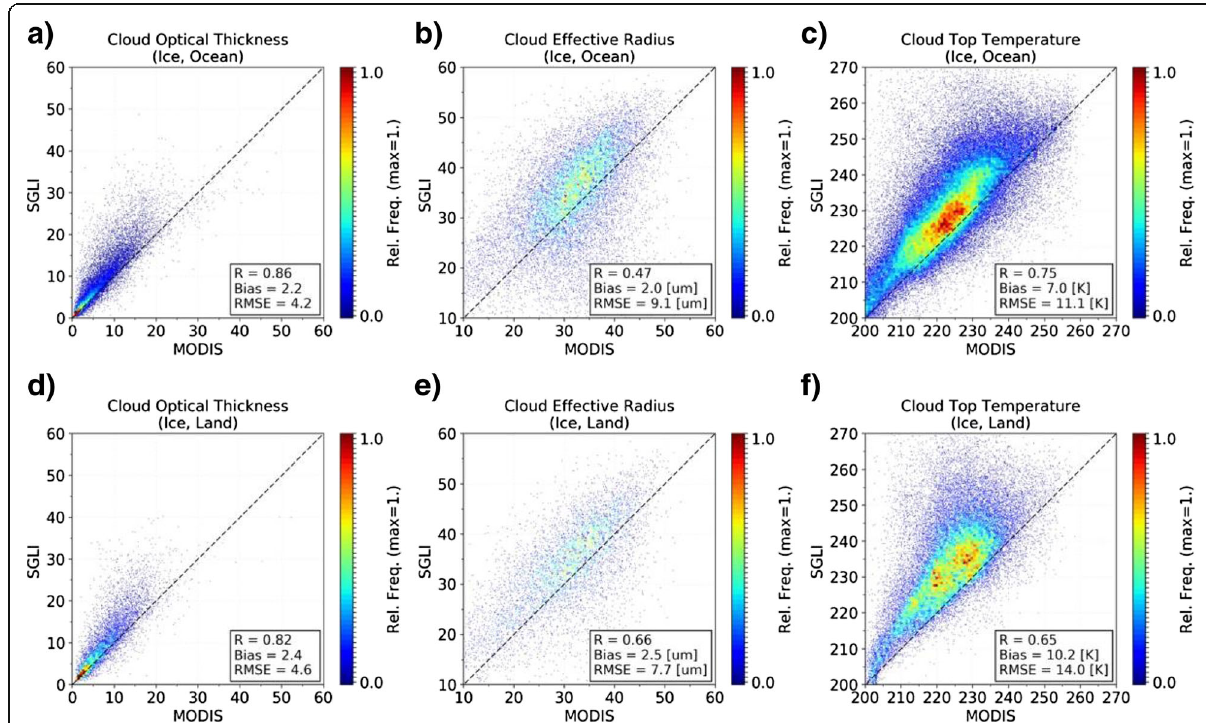
Fig. 18 Scatter plots of a , d optical thickness for ice clouds, b , e effective radius, and c , f top temperature for water clouds from the SGLI retrievals compared with the MOD06 retrievals. Panels ( a – c ) are for ocean and ( d – f ) are for